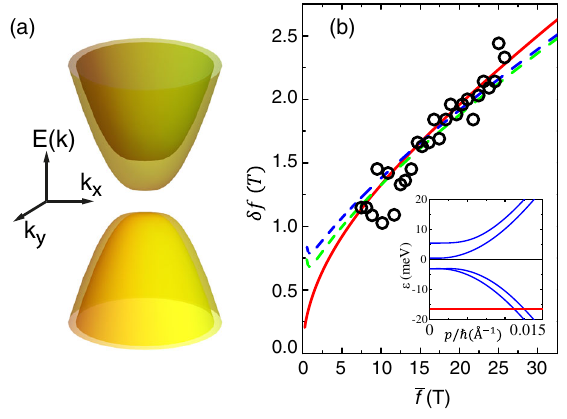
FIG. 8. (a) Low-energy band structure of bilayer graphene on TMD, obtained from the Hamiltonian in Eq. (3), with ¼ 13 meV, λ ¼ 5 meV. See the inset of panel U ¼ − 6 meV, λ R (b) for a numerically accurate band cross section, with the red line indicating the position of the Fermi energy calculated self- consistently as described in the text. (b) The circles represent the measured splitting δ f of the frequency of the SdH resistance ¯ f . The oscillations plotted versus the average frequency peak ¯ f are obtained from the data shown in Fig. 7(d) values of δ f and as the Fermi energy is swept through the valence band < − 2 V). The colored lines correspond to theoretical pre- ( V g dictions calculated using the band structure obtained with the Hamiltonian in Eq. (3) for different values of λ and λ . Three R ; λ Þ ¼ ð 15 ; 0 Þ meV (red solid line), possible best-fit plots with ð λ R ð λ ; λ Þ ¼ ð 13 ; − 5 Þ meV (green, dashed line), and ð λ ; λ Þ ¼ R R ð 13 ; 5 Þ meV (blue, dashed-dotted line) are shown. Note the electron-hole asymmetry in the band structure and, in particular, in the spin splitting, clearly visible in the inset of panel (b). As discussed in the main text, such an asymmetry may allow full gate tuning of SOI in double-gated bilayer